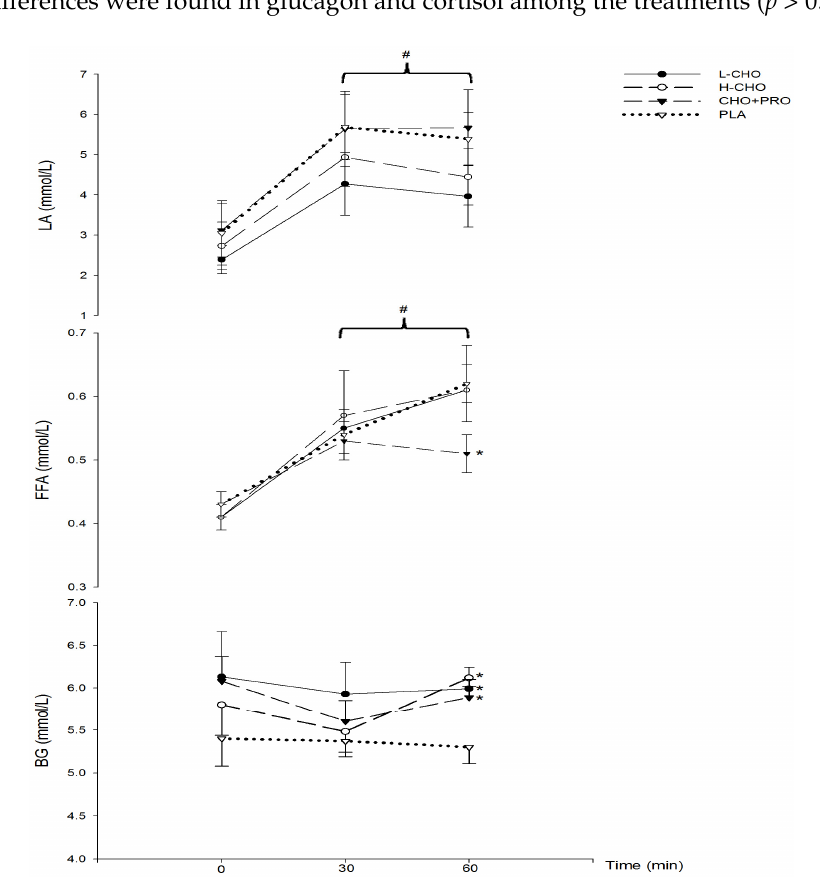
Figure 2. Changes of blood glucose (BG), lactate (LA) and free fatty acid (FFA) during the first exercise session ( # : vs. 0 min, p < 0.05; *: vs. placebo (PLA), p < Table 4. Blood hormonal change during exercise following treatments.